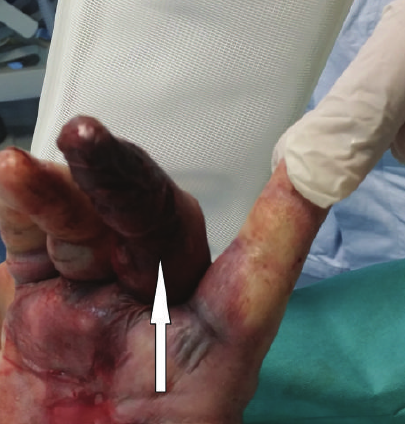
Figure 3: Initial necrotic lesion (white arrow).